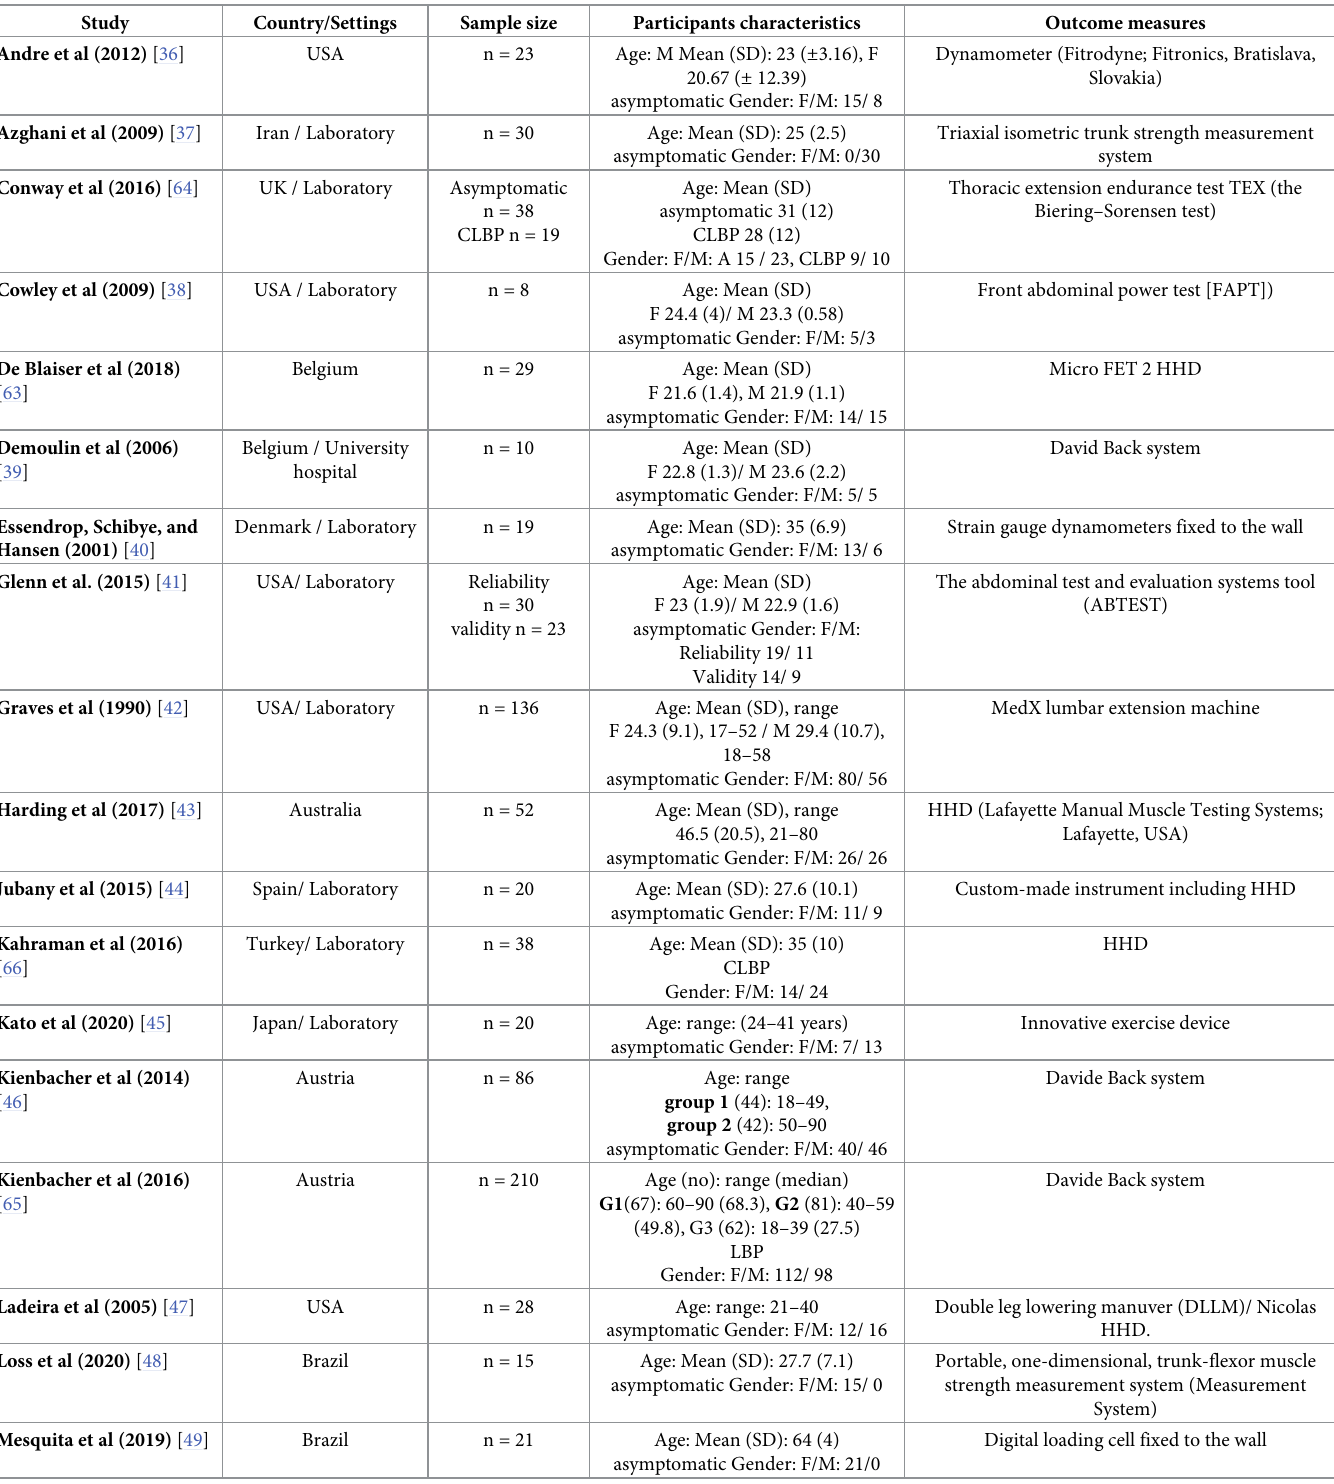
Table 1. Studies